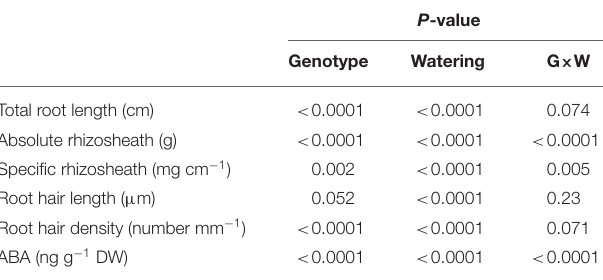
TABLE 1 | Root length, rhizosheath, root hair length and density, and root ABA concentration of not and WT plants grown under contrasting water regime conditions, with P -values for genotype (G), watering treatment (W), and their interaction (G × W) indicated.